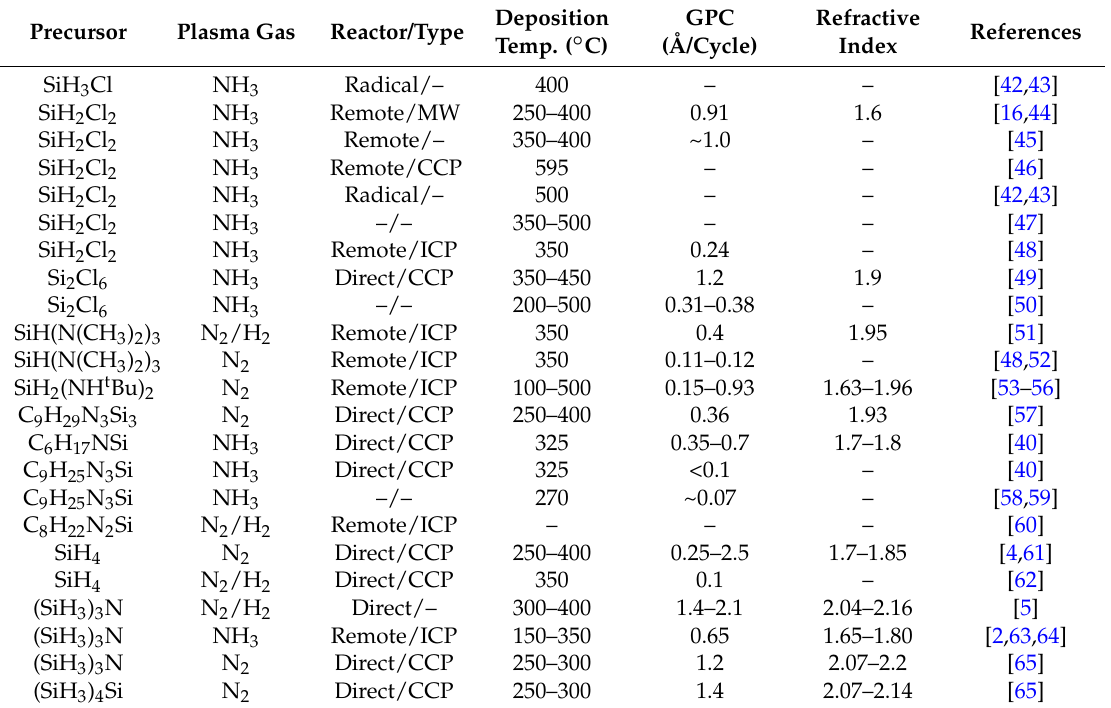
Table 2. Overview of silicon nitride thin films deposited by plasma-enhanced ALD.